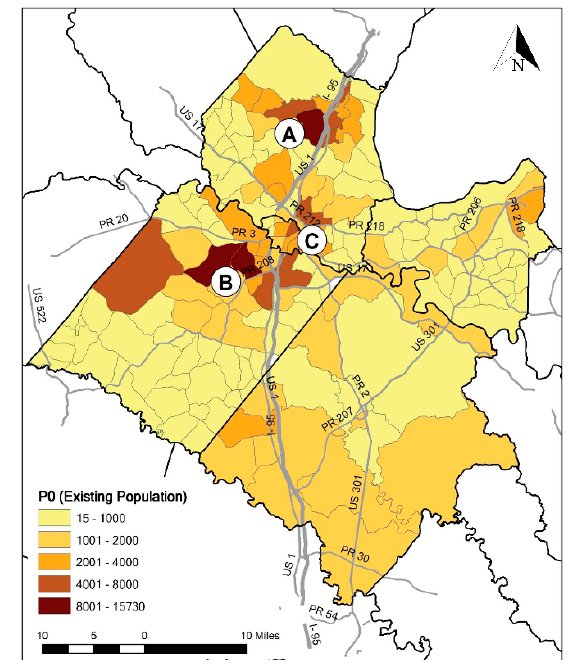
Figure 2. FAMPO Population in 2000.